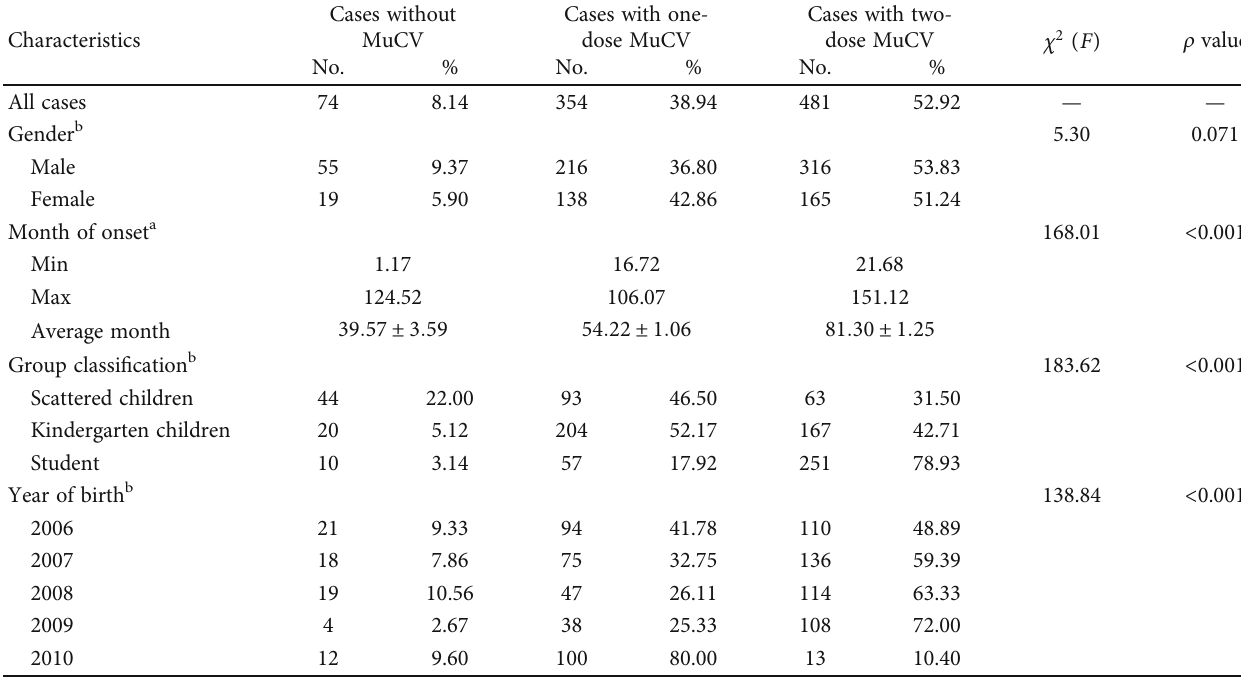
Table 2: Immunization rates of MuCV by social demographic characteristics among children born from 2006 to 2010 in Quzhou.